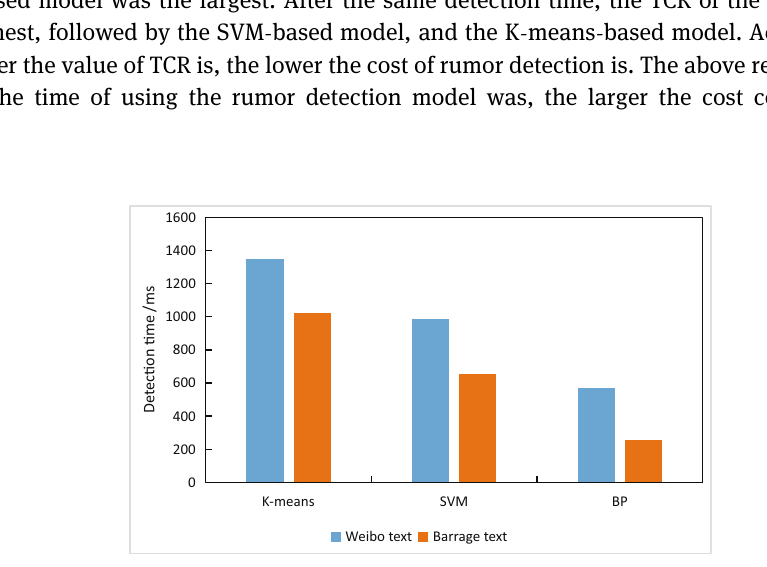
Figure 6: Recognition time consumption of three rumor evaluation models for Weibo texts and bullet screen texts.